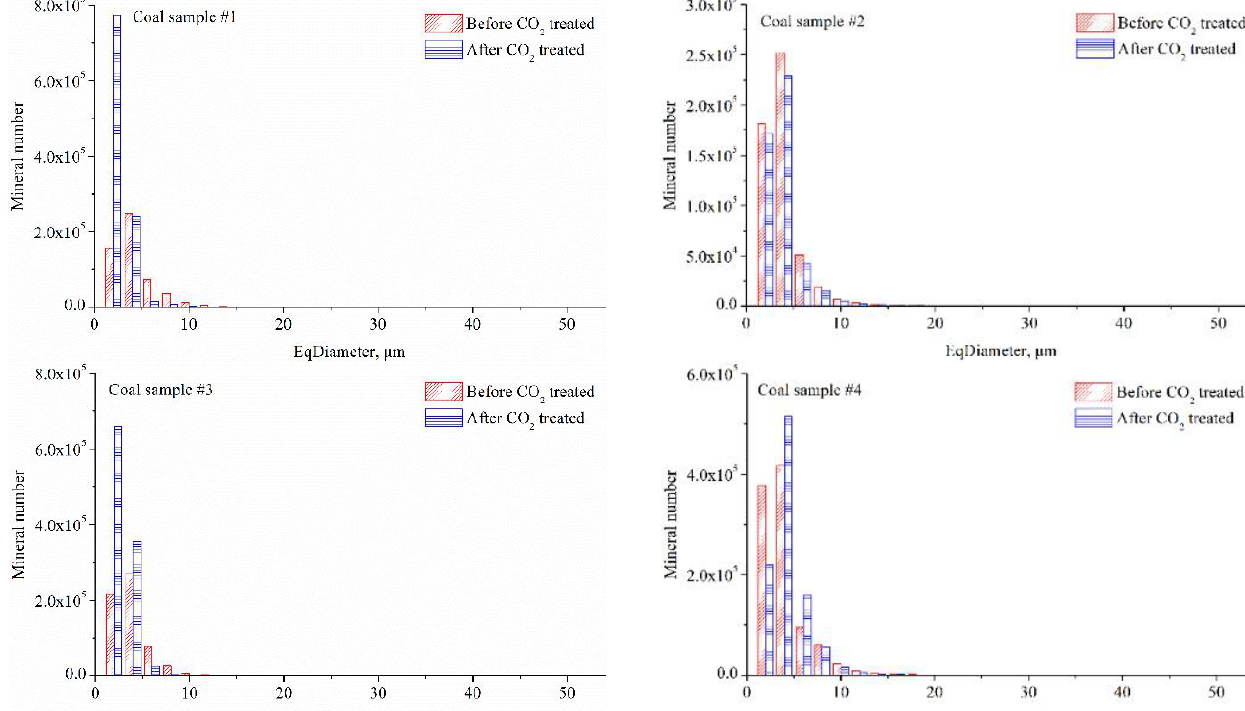
Figure 7—Mineral number distributions in the coal samples based on X-ray CT.